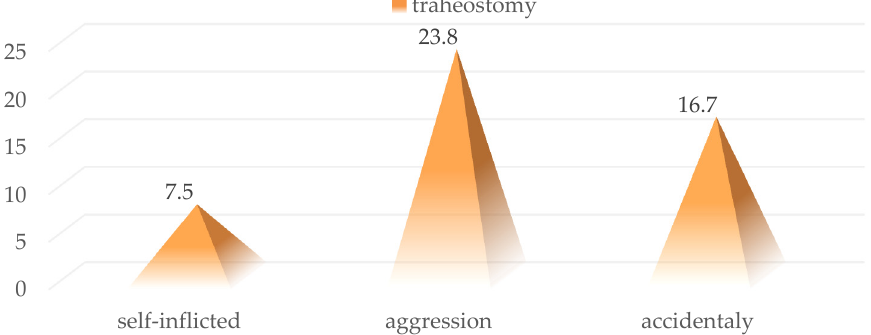
Figure 10. Distribution of cases in the batch in which tracheostomy was performed according to the lesion mechanism.